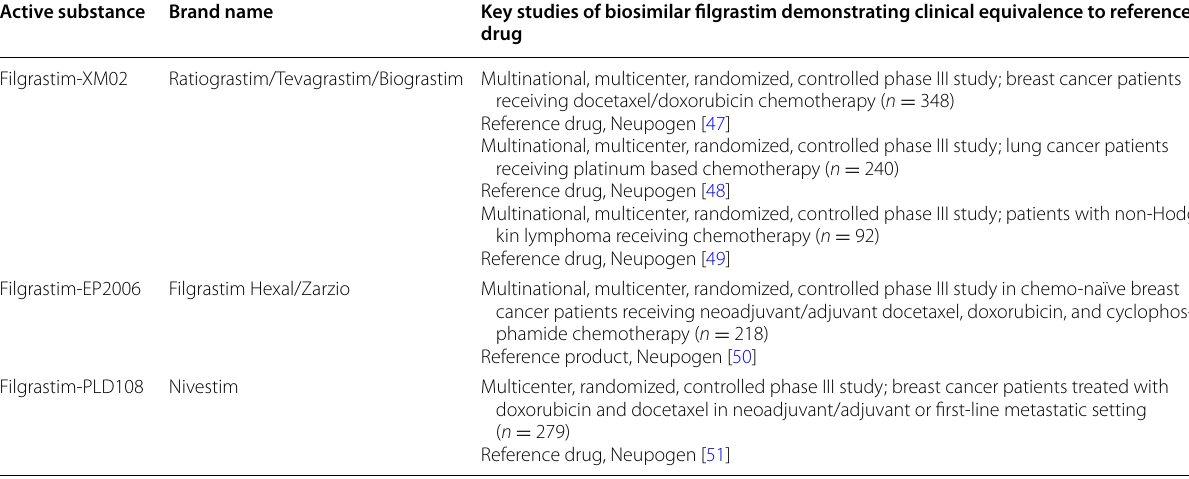
PK pharmacokinetics; PD pharmacodynamics